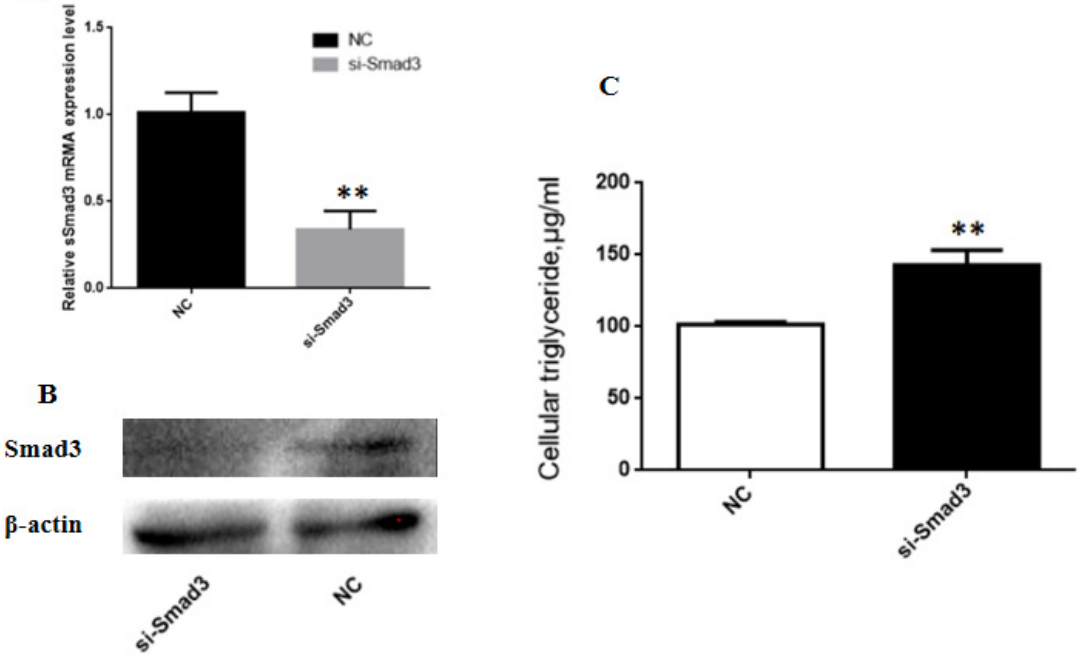
Figure 6. E ff ects of Smad3 on milk fat synthesis. ( A , B ) Comparative expression of Smad3 mRNA and protein in BMECs transfected with the si-Smad3 and negative control for 48 h. ( C ) Triglyceride levels in BMECs after treatment with the si-Smad3. ** p < 0.01.